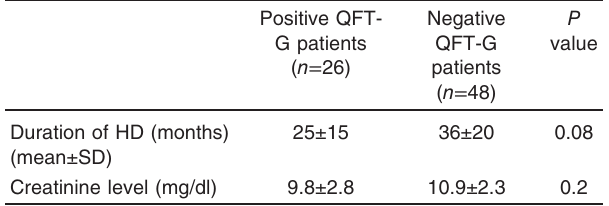
Table 2 Relationship between QuantiFERON-Tuberculosis Gold results and duration of hemodialysis and creatinine levels in the studied